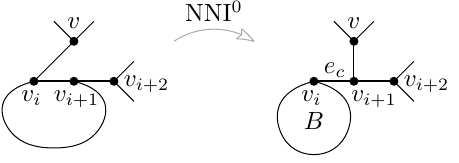
Figure 7: How an NNI 0 in the proof of Lemma 3.4 may result an improper network where e separates a blob B from all leaves. The moving edge { v, v c edge { v, v } of N . Labels follow the definition of NNI 0 along an i +1 i +1